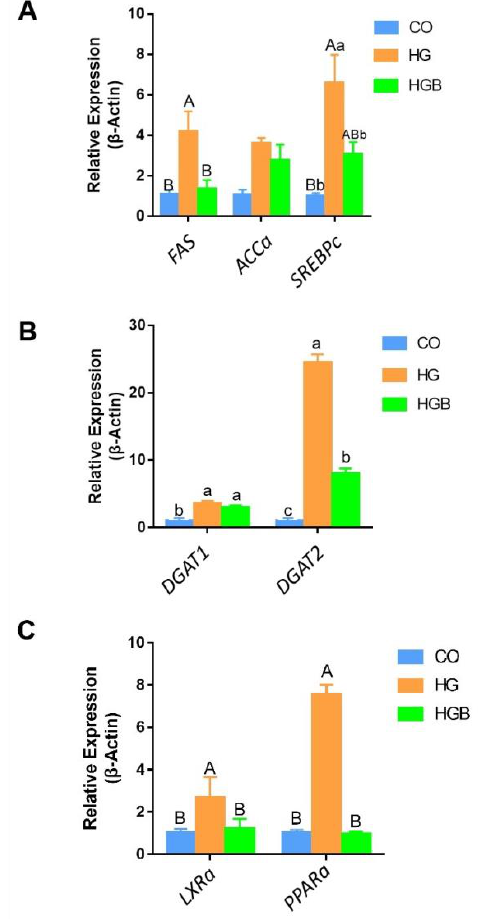
Figure 7. The changes of key genes for fat synthesis, deposition, and metabolism with different treatments. ( A ): The key genes’ ( FAS , AAC α , and SREBPc ) expression levels of fat synthesis pathway; ( B ): The key genes’ ( DGAT1 and DGAT2 ) expression levels of fat deposition; ( C ): The key genes’ ( LRX α and PPAR α ) expression levels of lipid regulation metabolism. Different lowercase letters indicate a significant difference ( p < 0.05), and the different capitals indicate an extreme difference ( p < 0.01).CO: control group (0 mmol/L of glucose + 0 mmol/L of betaine); HG: 20 mmol/L of glucose + 0 mmol/L of betaine group; HGB: 20 mmol/L of glucose + 20 mmol/L of betaine combined treatment